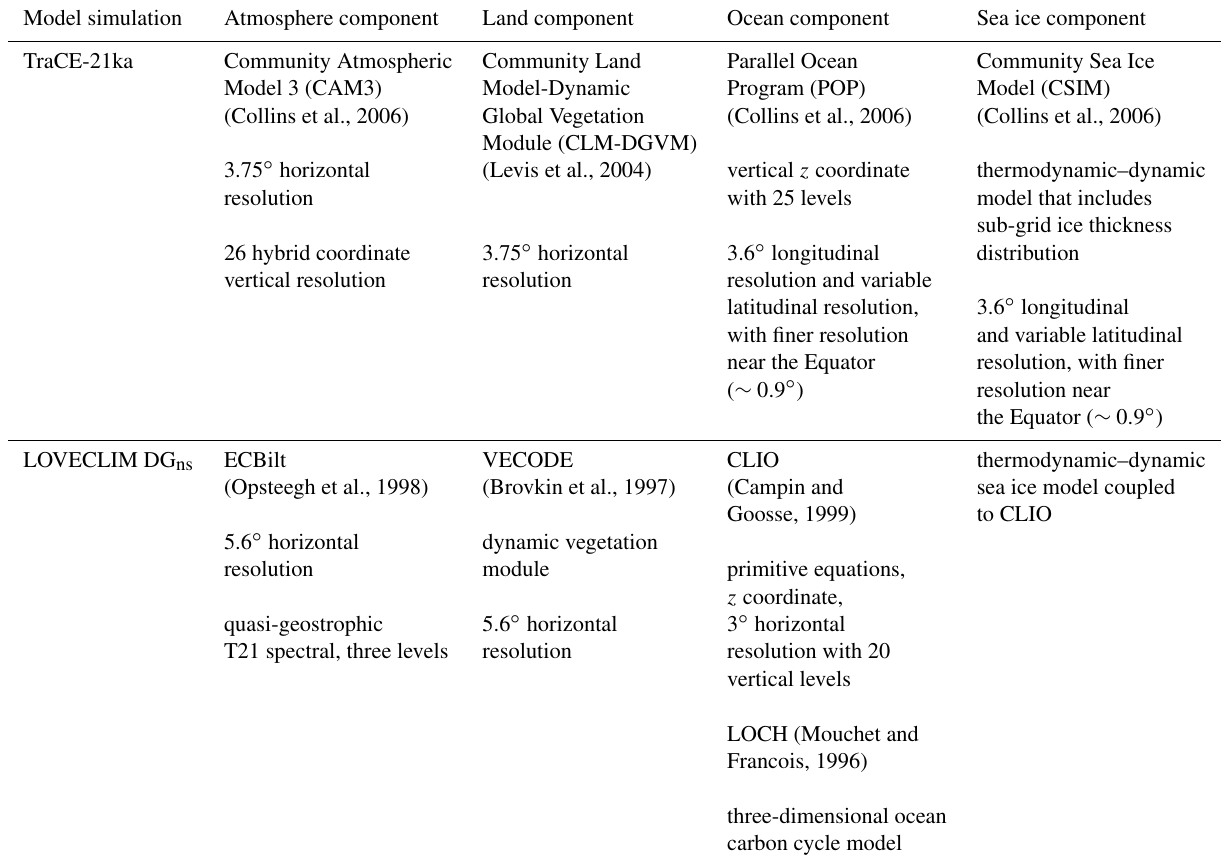
Table 1. Model details and